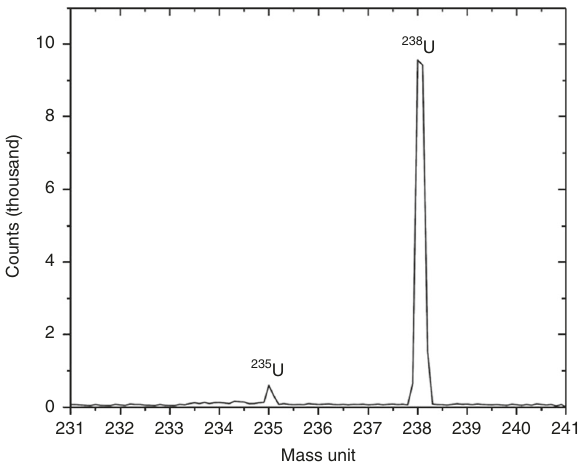
Fig. 4 Uranium mass spectra: mass spectra between 231 and 241 amu obtained from the U particle contained within the CF-01 bulk particle (as identi fi ed in Fig.